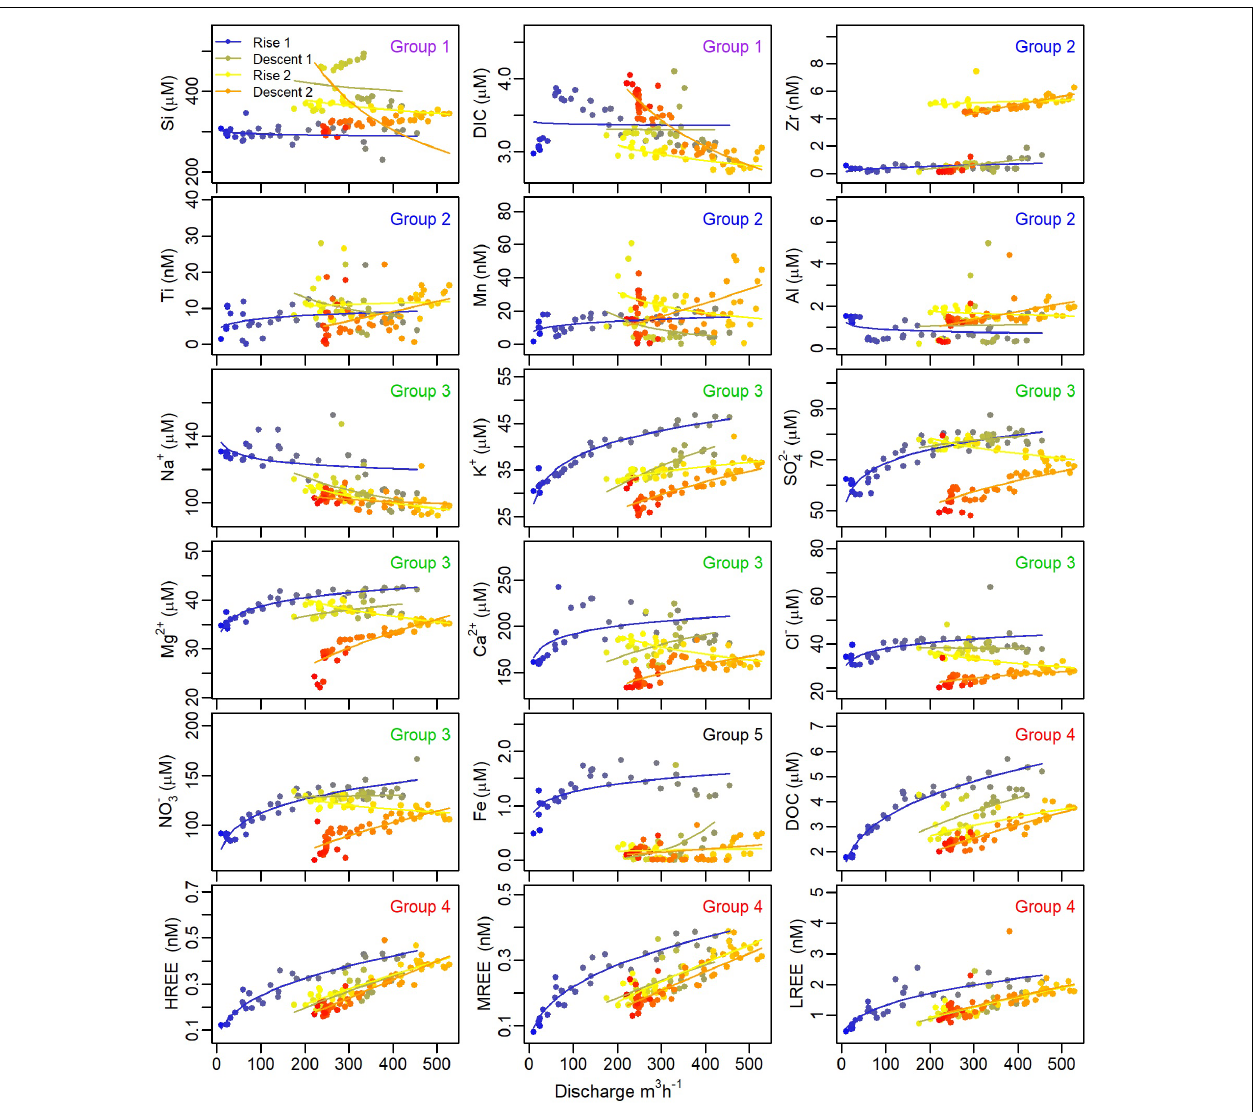
FIGURE 4 | La Jara flume C-Q relations for selected elements. Solids lines are best fits to power law (Eq. 1) for each of the four hydrographs limbs: first rising (blue), first falling (green), second rising (yellow), and second falling (orange). See Table 2 for extracted parameters and associated statistics. Group numbers in each plot are linked to Figure 6